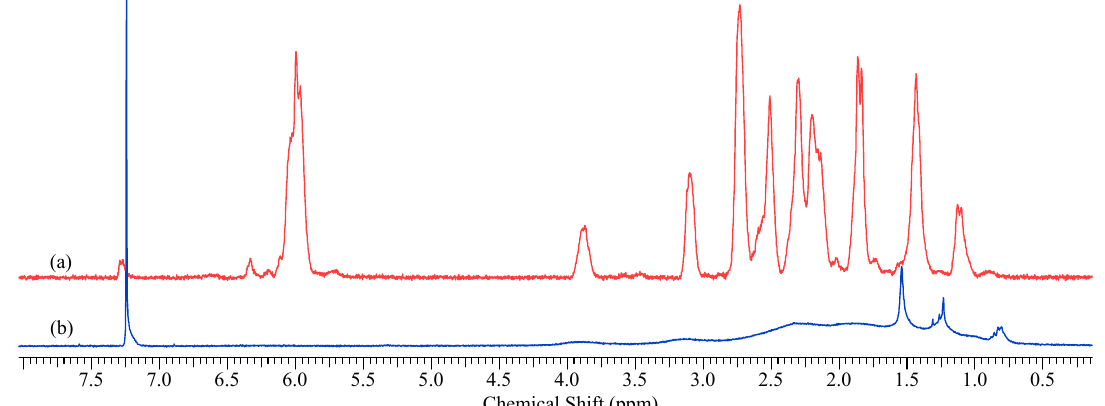
Figure 4. 1 H NMR spectra of ( a ) 3-pentafluorophenyltricyclononene-7 and ( b ) its addition polymer (CDCl 3 ).